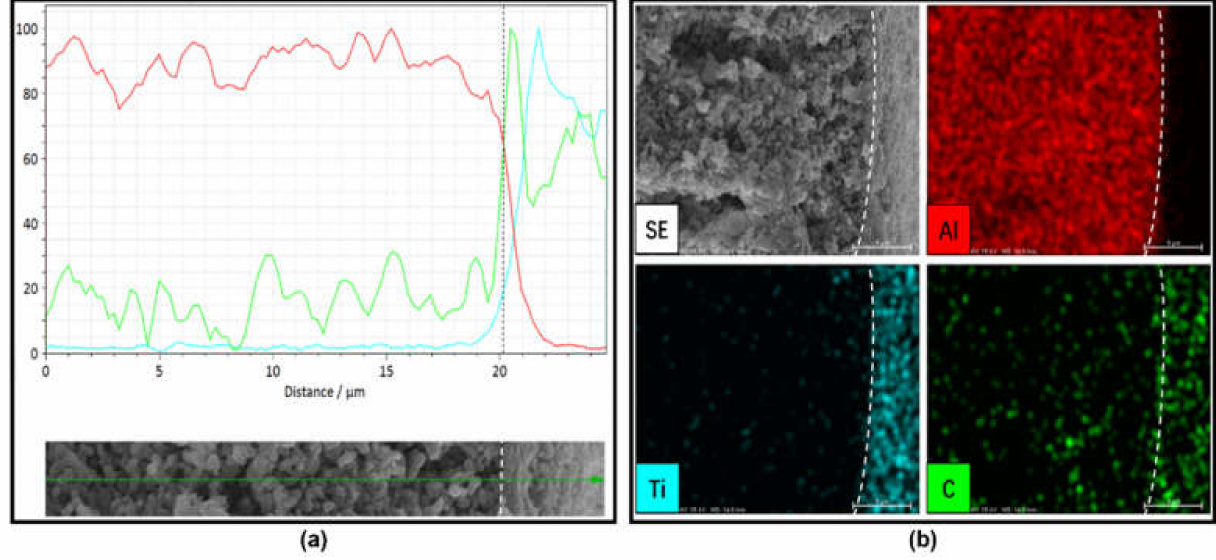
Figure 3. EDS ( a ) line analysis and ( b ) map analysis for the TiO 2 /GO-Al 2 O 3 HF NF membrane interface. The distributions of the Al, Ti, and C elements are highlighted by lines and images using different